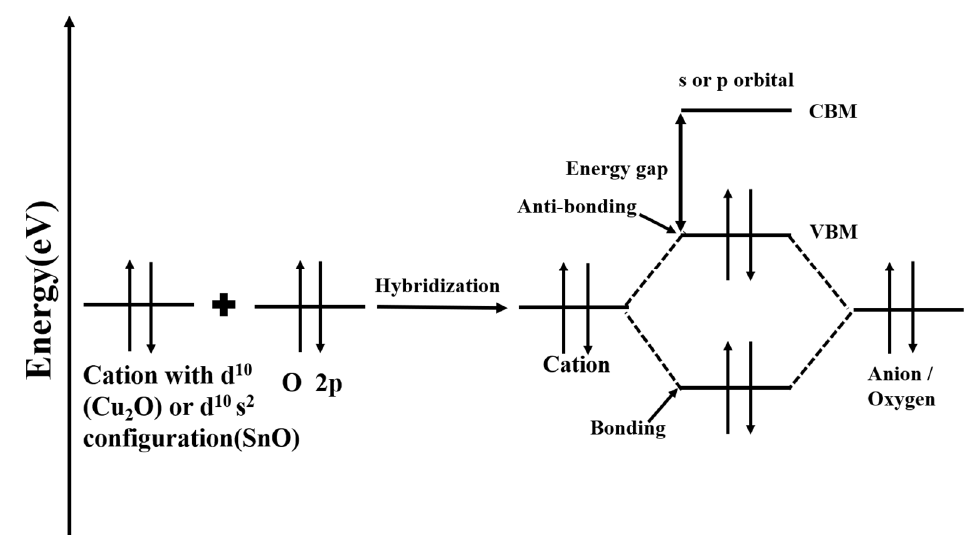
Figure 3. Chemical modulation of the valence band between a closed or pseudo-closed metal configuration and an oxide ion [30,37].